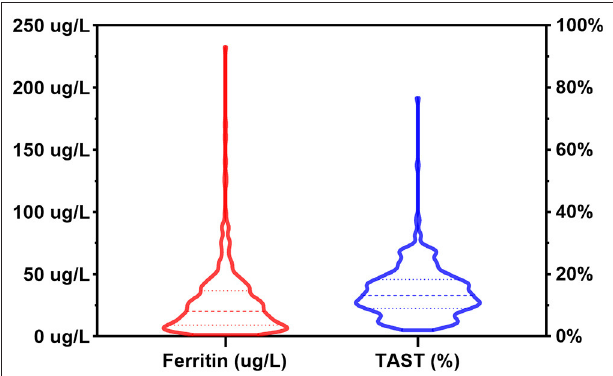
FIGURE 2 | Distribution of serum ferritin levels and transferrin saturation in the patient population. TAST, transferrin saturation.